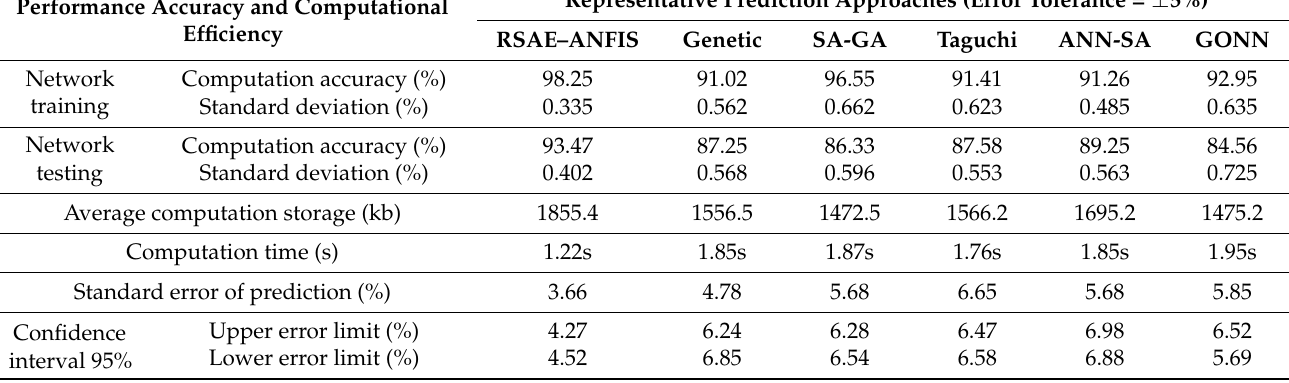
Table 5. Performance comparisons of RSAE–ANFIS approach with others, such as SA-GA, simulated annealing-genetic algorithm; ANN, artificial neural network; GONN, genetically optimized neural